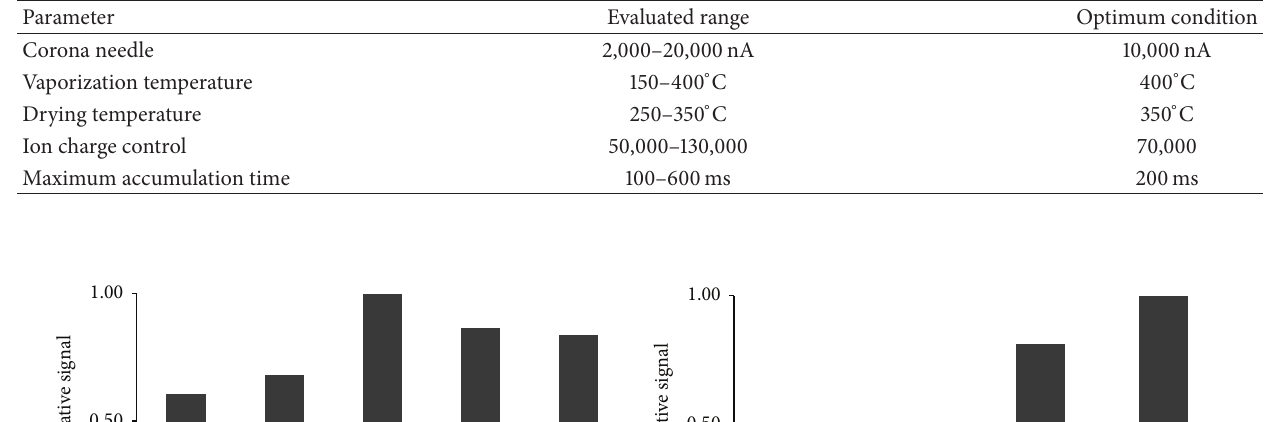
Table 2: Evaluated parameters for optimum response of hydrazones derivatives by APCI/MS.